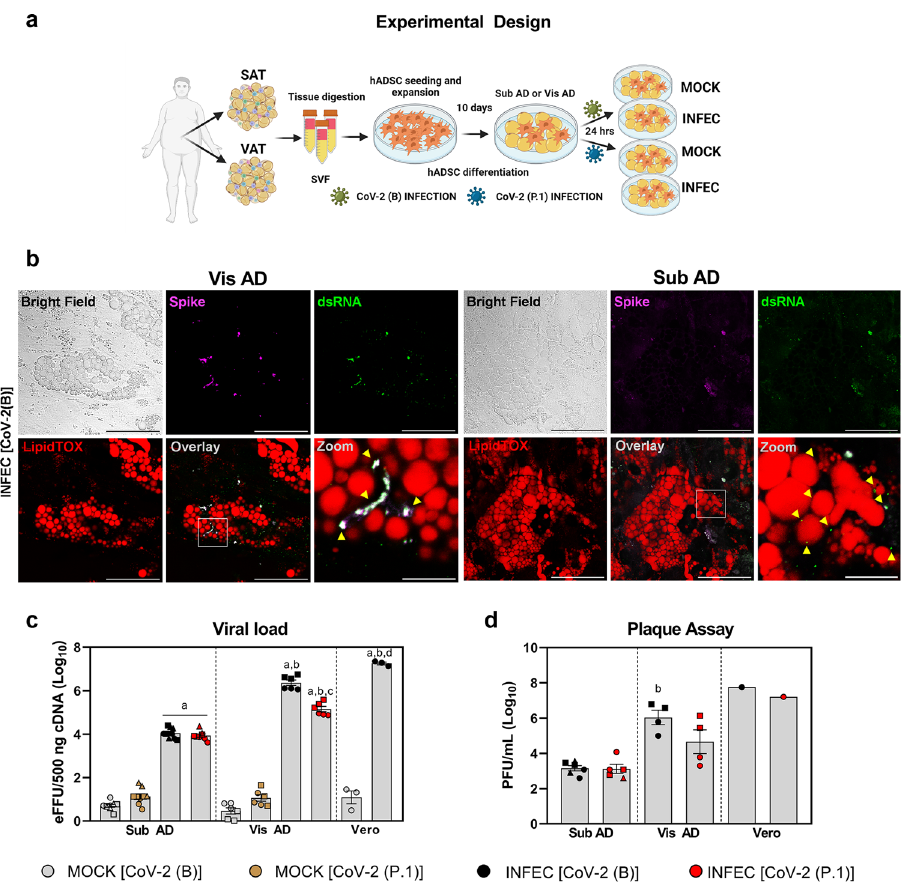
Fig. 2 | The degree of adipose tissue cell infection depends on the anatomical origin of the cells and the SARS-CoV-2 lineage. a Human adipose-derived stro- mal-vascular cells (hADSCs) were obtained from abdominal subcutaneous (SAT) and omental visceral (VAT) adipose tissues, differentiated in adipocytes (Sub AD andVisAD,respectively),andinfected(INFEC)ornot(MOCK)withtheSARS-CoV-2 ancient strain [CoV-2 (B)] or the P.1 variant [CoV-2 (P.1)]. Created with Bior- ender.com. b Cells were infected with MOI=0.1 for 1h and harvested 3 days after infection to allow better contrast and resolution of the replicating viruses. Repre- sentative immuno fl uorescence of six to ten images acquired from two to six independent pools of cells from two to three donors. SARS-CoV-2 spike protein, magenta. Double-stranded RNA (dsRNA), green. LipidTOX, red. Scale bar=50 µ m (zoom=10 µ m). c , d